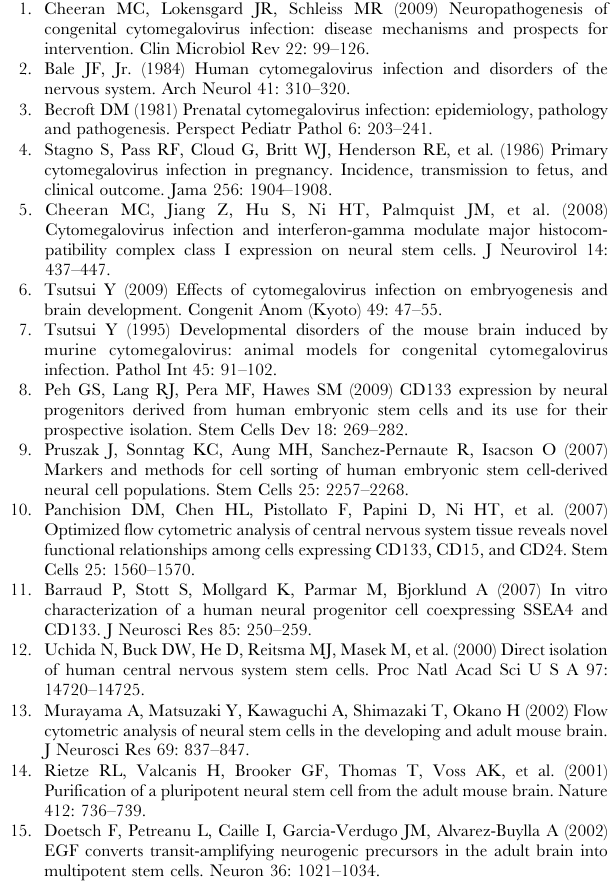
Figure S4 Immune responses to MCMV brain infection predominantly consist of macrophages. At 7 d p.i., leukocytes were isolated from MCMV-infected neonatal brains. Brain